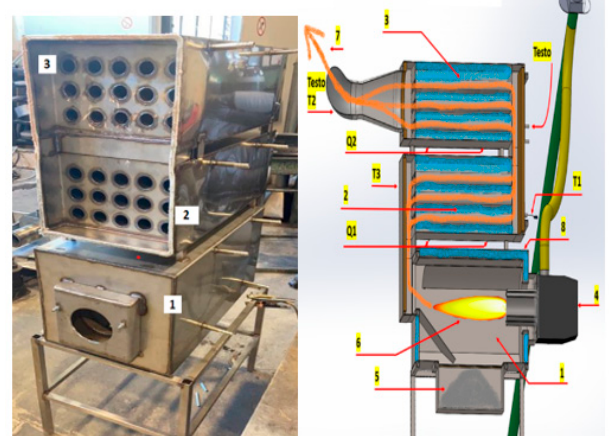
Figure 2. A digital image ( left ) and schematic sketch ( right ) of experimental device: a, b: 1—combustion chamber block (furnace), 2, 3—heat exchangers; 4.—burner, 5.—ash collector, 6.—flame, 7.—flue gases pathway, 8.—water supply to combustion chamber, T1, T2, T3—flue gas temperature measurements, Q1, Q2—calorimetric measurements of the cooling water flow.